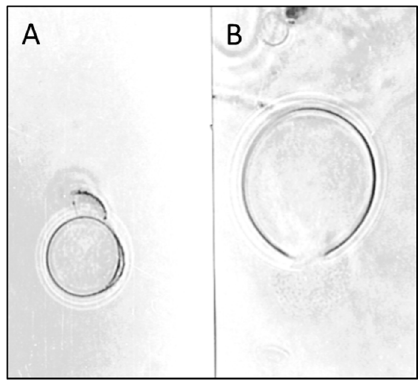
Figure 3. Cultures of Mucor plumbeus treated with the purified chitinolytic enzyme (CHI) of L. muscarium CCFEE 5003 and showing protoplast formation, with traces of degraded cell wall, ( A ) and bursting ( B ) (unpublished picture related to [43]).